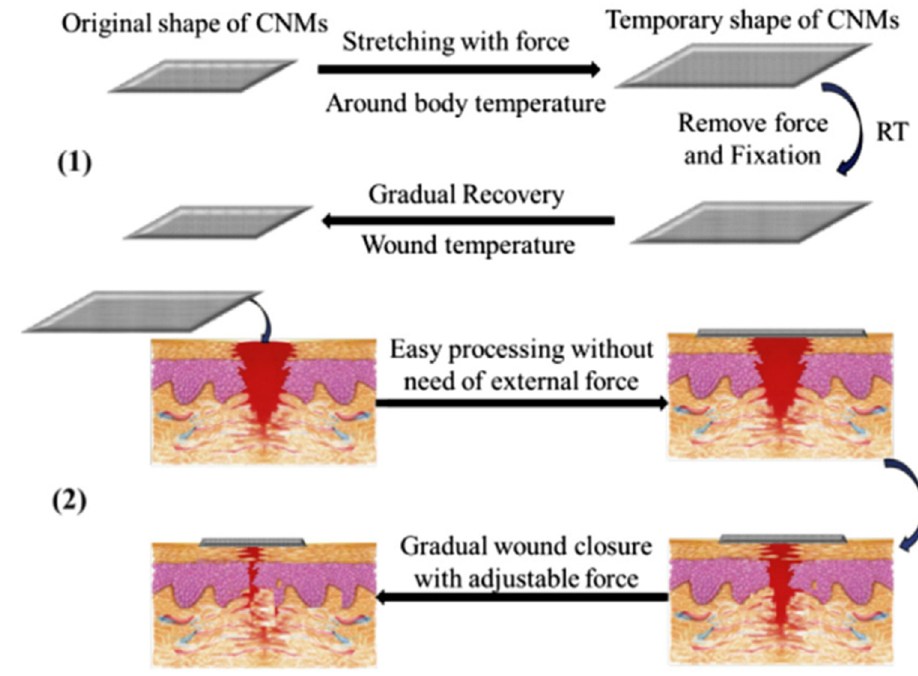
Figure 17. Schematic illustration of wound closure process by using CNMs [182].